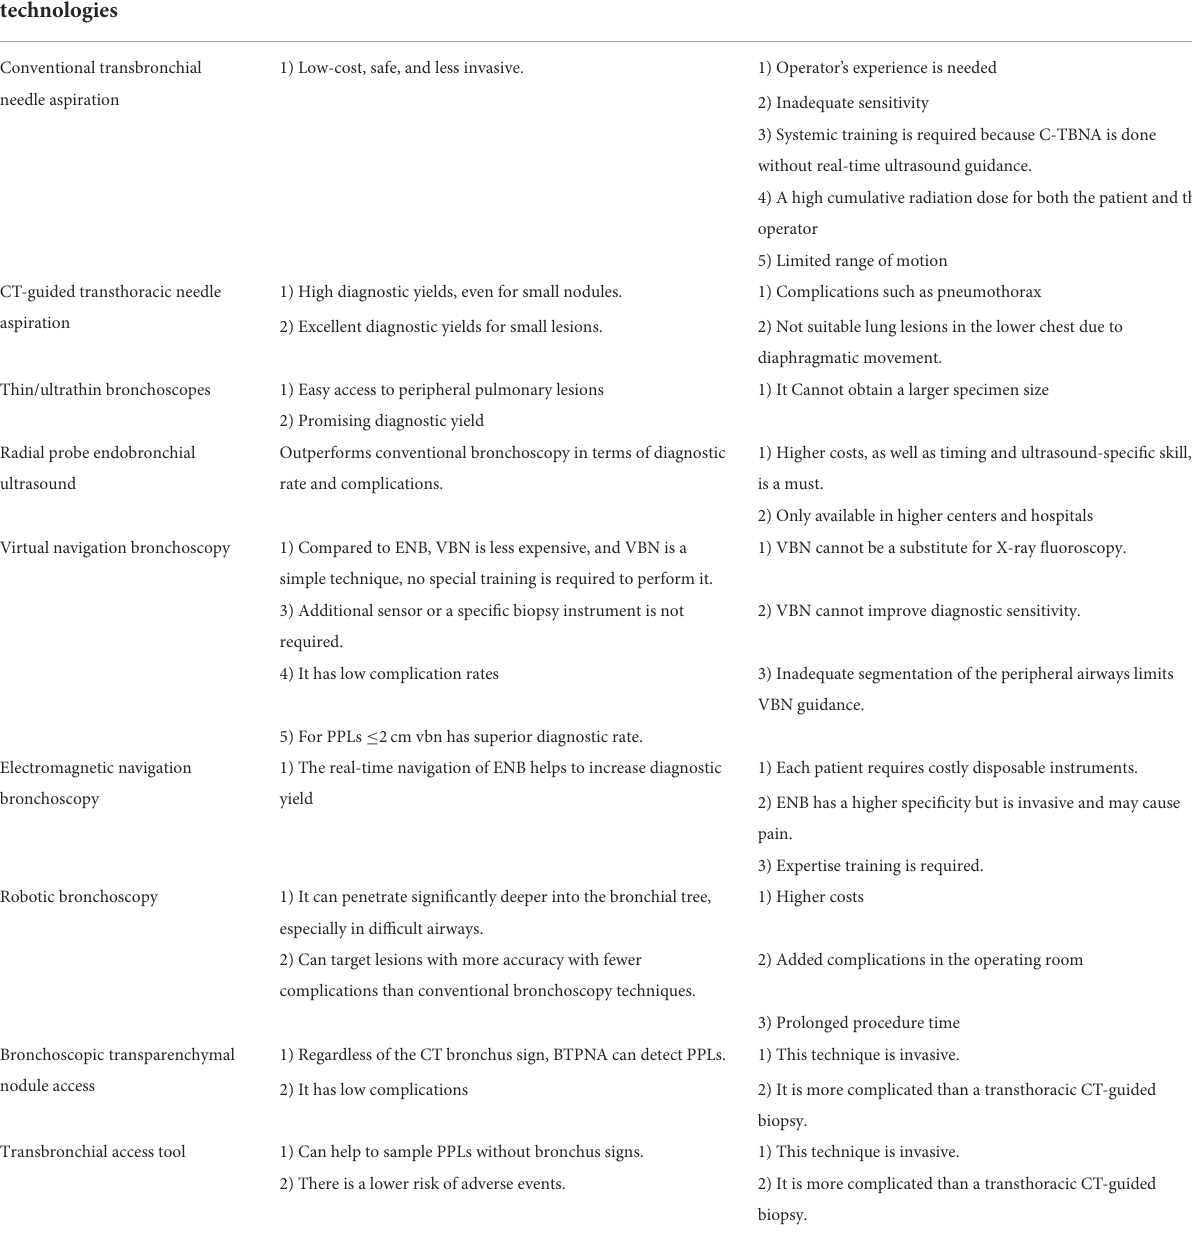
TABLE 2 Summary of the advantages and disadvantages of bronchoscopic technologies for diagnosing